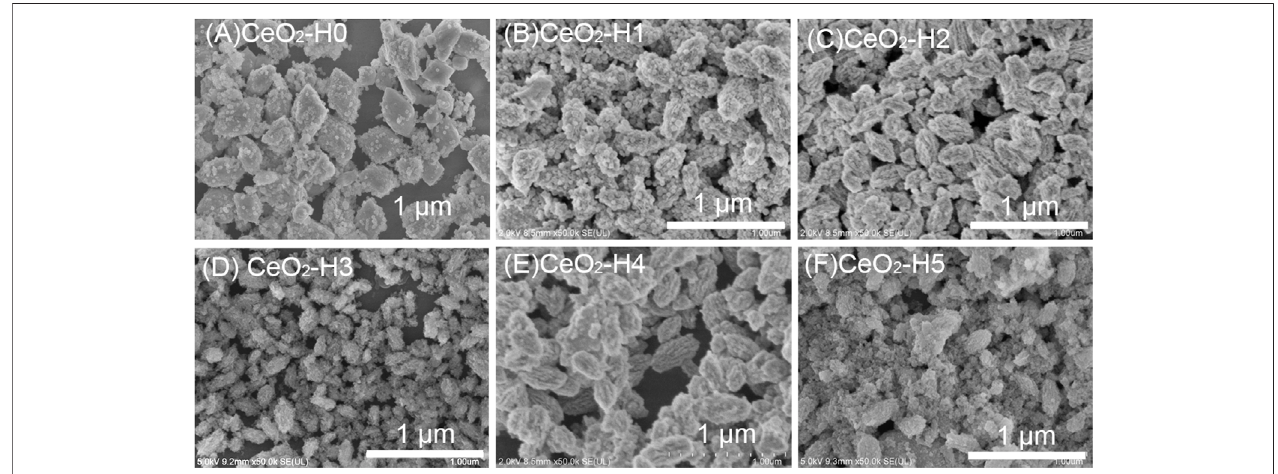
FIGURE3| SEMmorphologiesofCeO 2 preparedbythecombinedmicrowave – ultrasonicmethodandcalcinedat500 ° Cinairfor1 h. (A) CeO 2 -H0, (B) CeO 2 -H1, (C) CeO